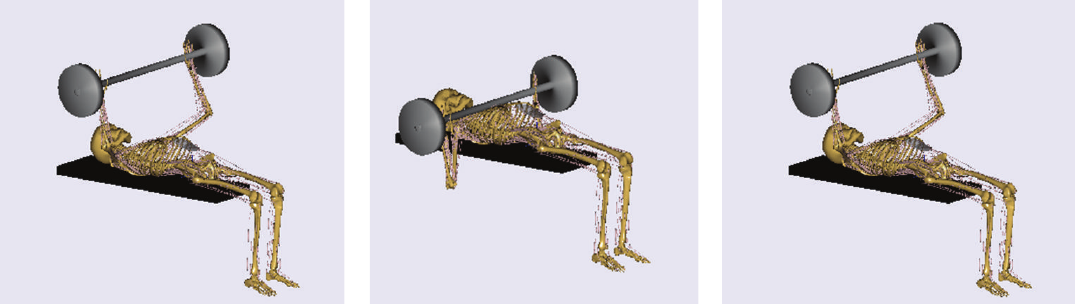
Figure 1: The three stages of the bench press.